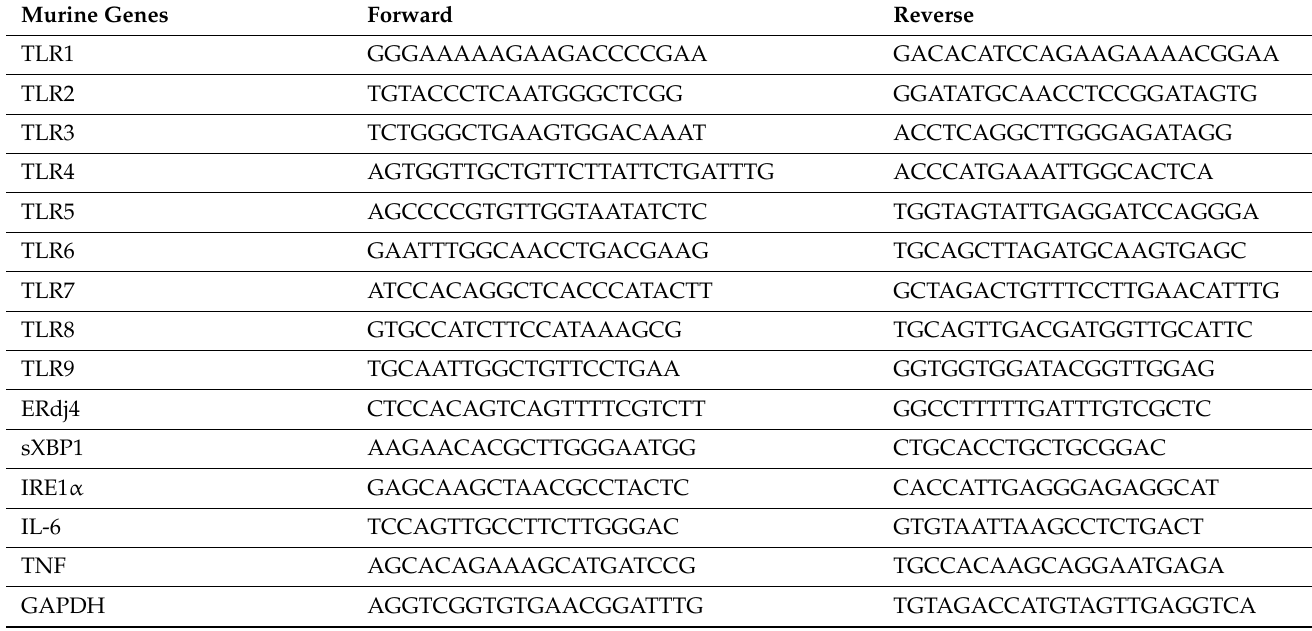
Table 2. List of murine primer sequences for